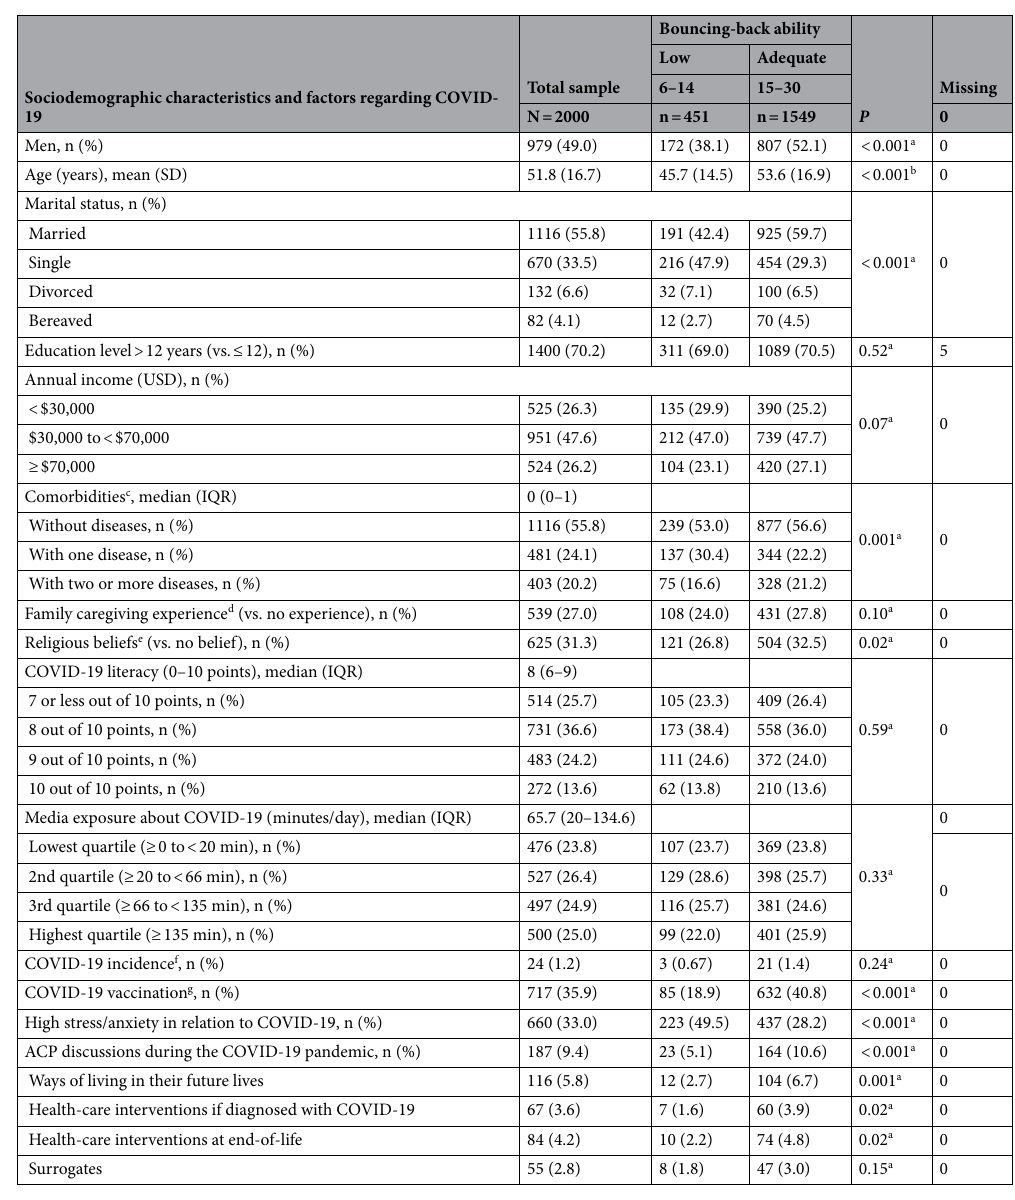
Table 1. Respondents’ sociodemographic characteristics and factors regarding COVID-19. IQR interquartile range, ACP advance care planning. a Chi-square test. b Student’s t -test. c Comorbidities were defined as the sum of the number of the following diseases or medical conditions: hypertension, hypercholesterolemia, diabetes mellitus, cerebrovascular disease, cardiac disease, respiratory disease, gastrointestinal disease, renal disease, urologic disease, hematologic disease, orthopedic disease, rheumatologic disease, neurological and psychiatric disease, endocrine disease, and neoplasm. d The question to the participants: “Do you have experience as a family caregiver?”. e The question to the participants: “Do you have any religious beliefs or affiliations?”. f